Question: Sum up the contents of this chart in one sentence.
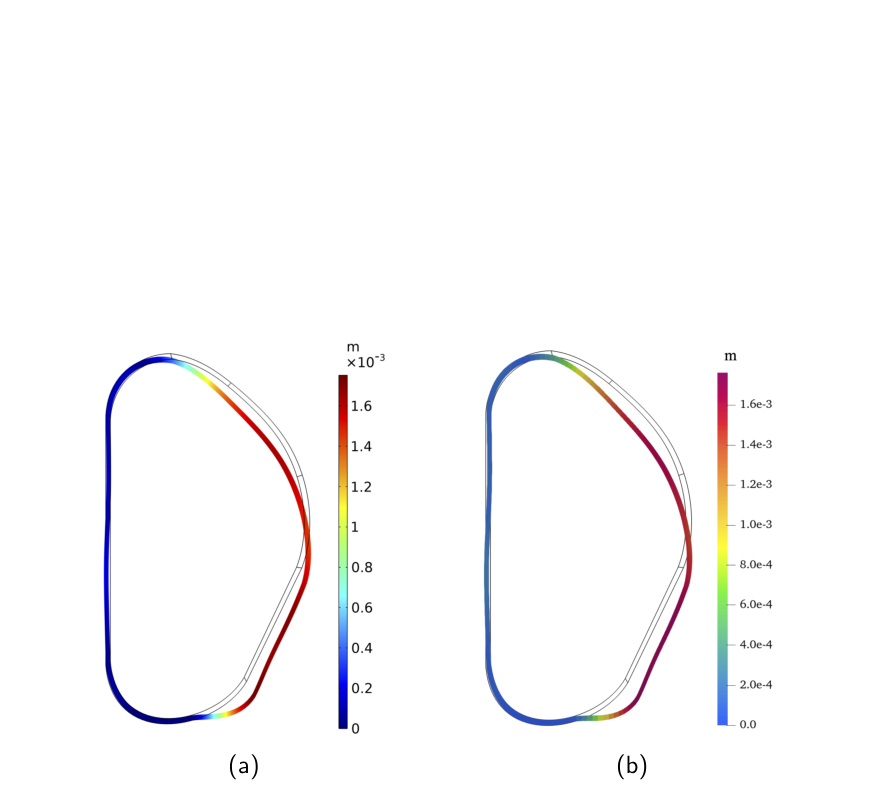
Answer: (a) Norm of the displacement field at t = 0.63 s evaluated with the 2D axisymmetric model in COMSOL®. (b) The magnitude of the displacement field at t = 0.63 s evaluated with the ROM. Graphically the displacement is amplified by a factor α = 300.